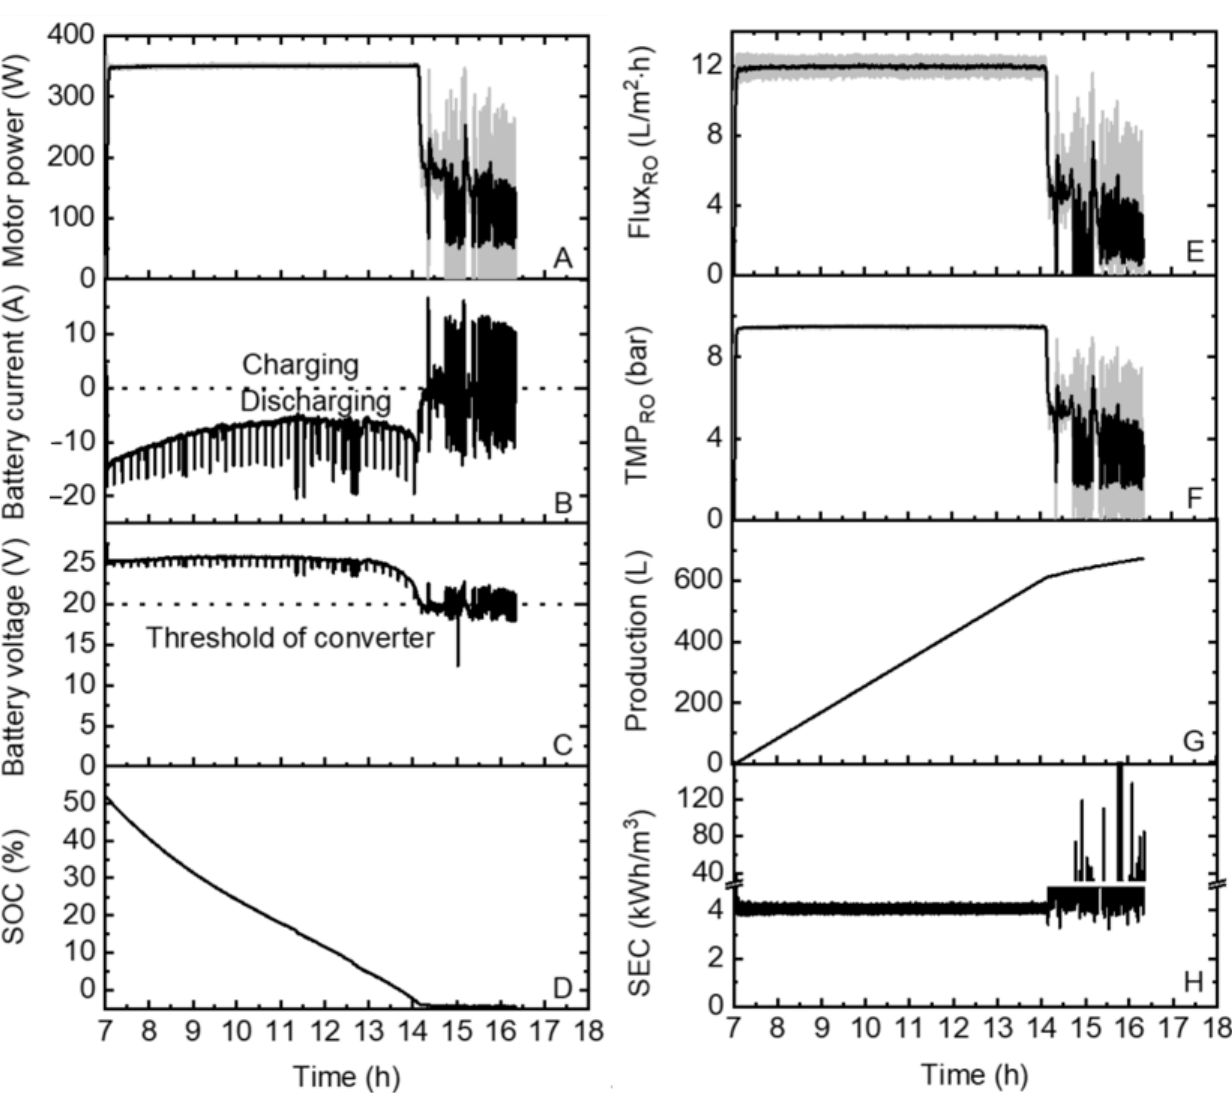
Figure 5. The performance of the PV-membrane system equipped with batteries at a 50% SOC on the “partly cloudy day”, indicating ( A ) the pump power, ( B ) battery current, ( C ) battery voltage, ( D ) SOC, ( E ) Flux RO , ( F ) TMP RO , ( G ) production and ( H ) SEC. Note that the black curves on graphs ( A ), ( E ) and ( F ) are the moving average values of 10 points, while the grey curves are the original measurement data from the